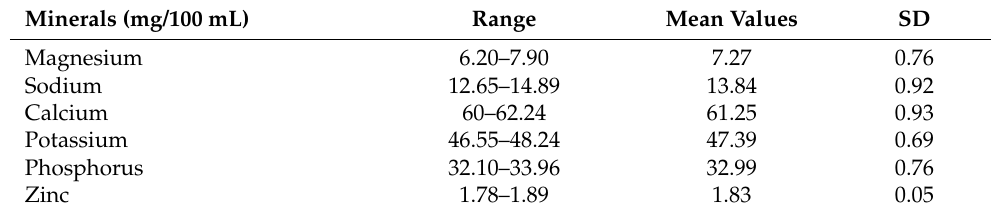
Table 2. Minerals in Halari donkey milk.